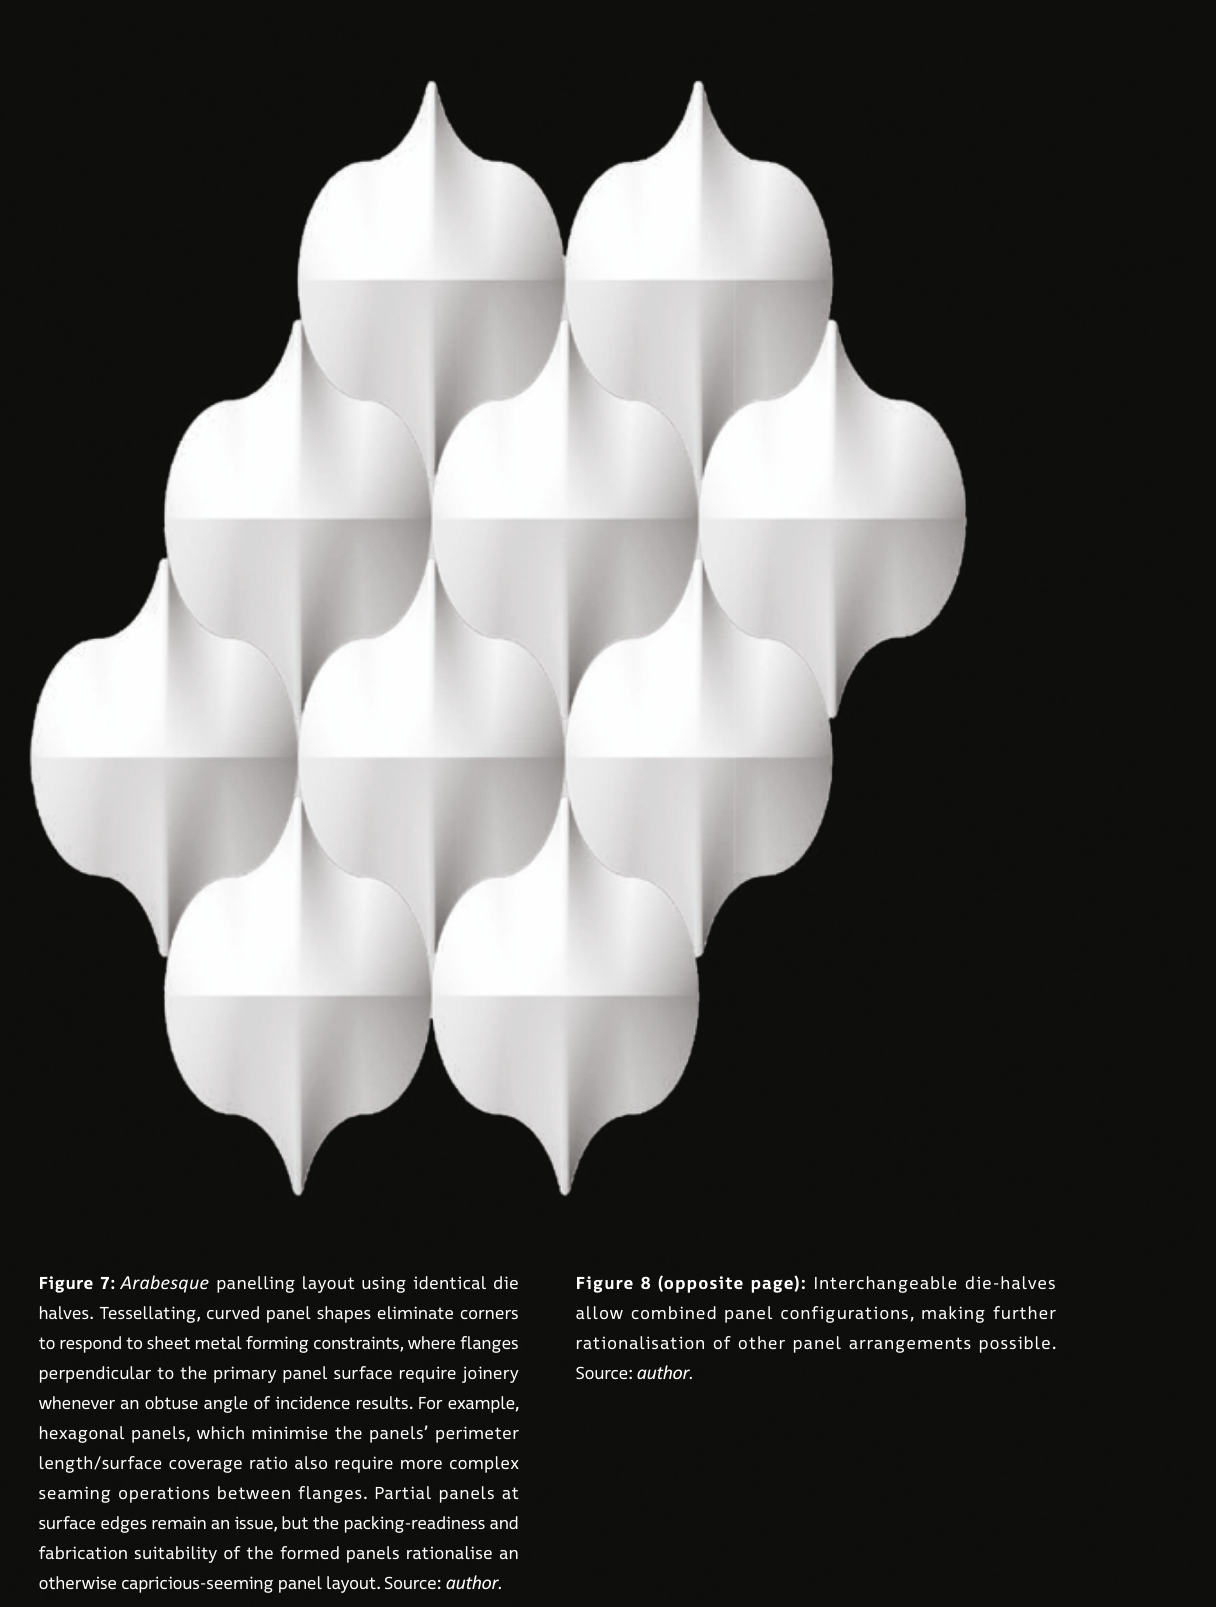
Figure 8 (opposite page): Interchangeable die-halves allow combined panel configurations, making further rationalisation of other panel arrangements